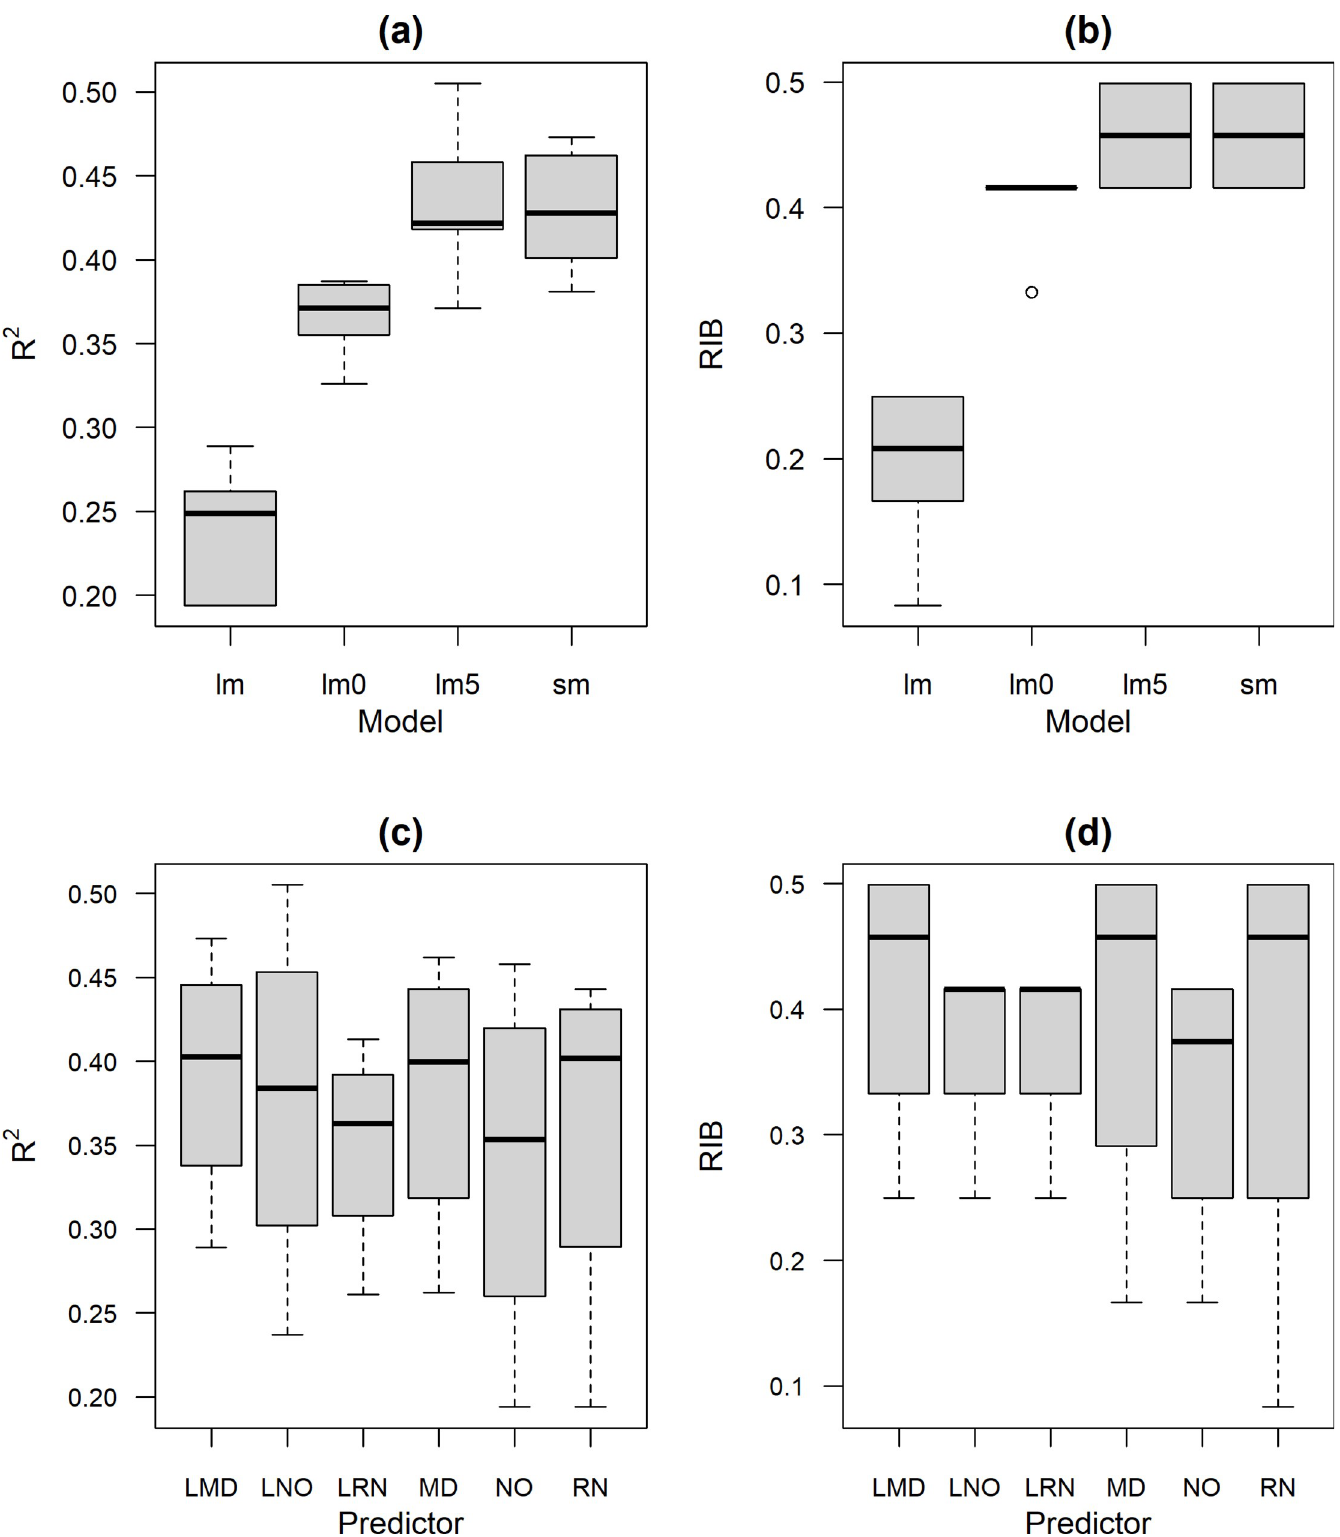
Fig 4. Assessment of the quality of an insurance index using R 2 and the Relative Insurance Benefit ( RIB ) measure for different regression models (a & b) and remote sensing predictor variables (c & d). Four regression models were used: linear (lm), piecewise linear with z -scores less than 0 (lm0), piecewise linear with z -scores